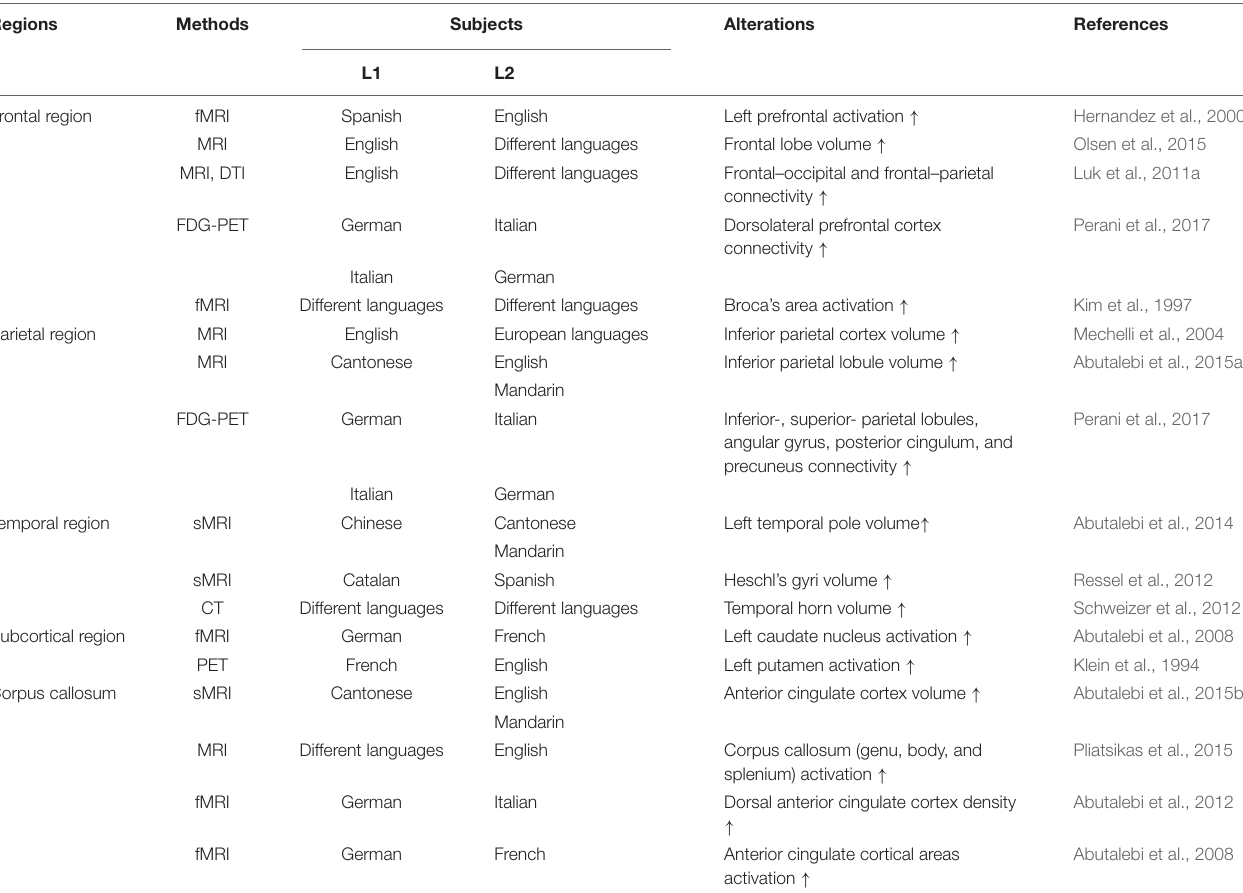
TABLE 2 | The alterations of radiological imaging in bilingualism.